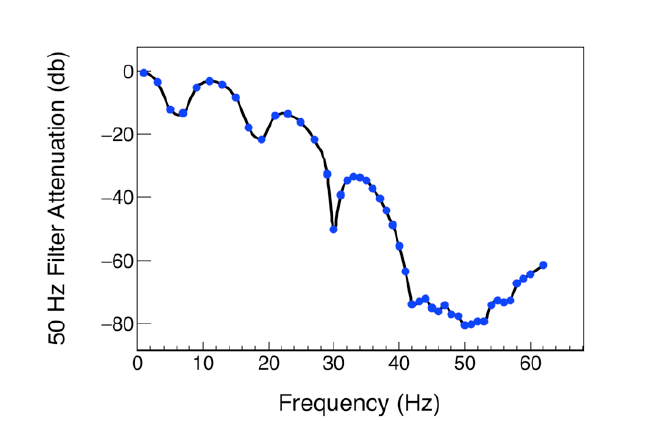
Figure 6. Normal Mode Rejection Ratio as a function of the input signal